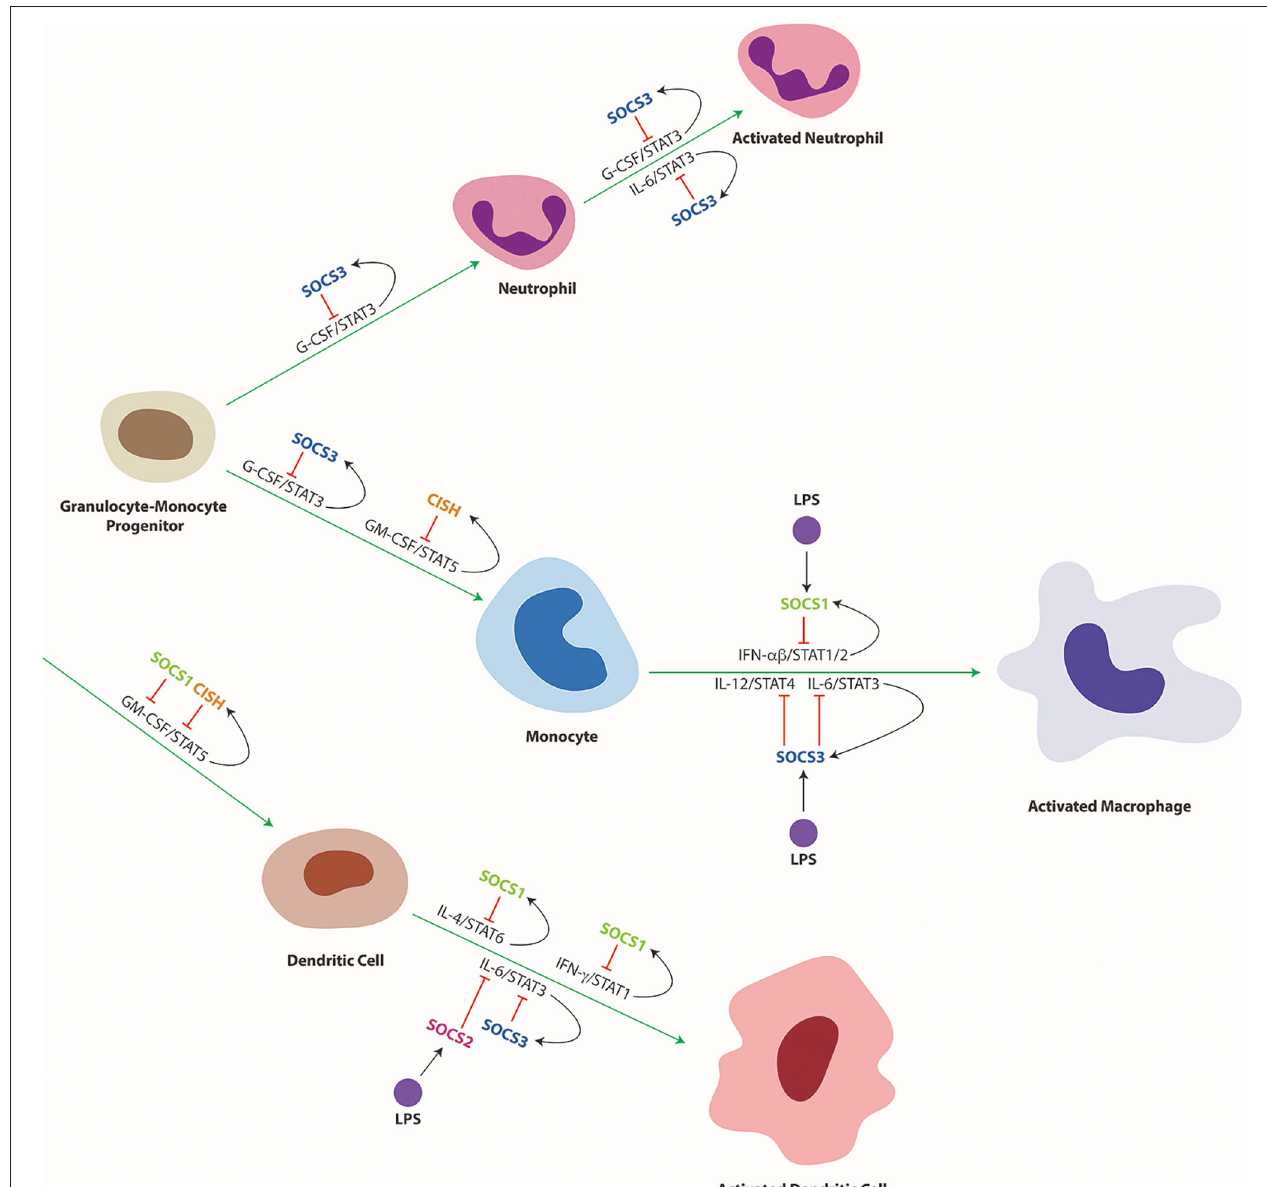
FIGURE 5 | Cytokine mediated differentiation and activation of myeloid cells and its regulation by SOCS proteins. Schematic representation of myeloid cell differentiation along the indicated lineages, including their subsequent activation as well as its control by specific cytokines and downstream STAT proteins and their regulation by specific SOCS proteins. Green arrows indicate stimulation and red lines indicate suppression of developmental pathways, with black arrows delineating SOCS induction.